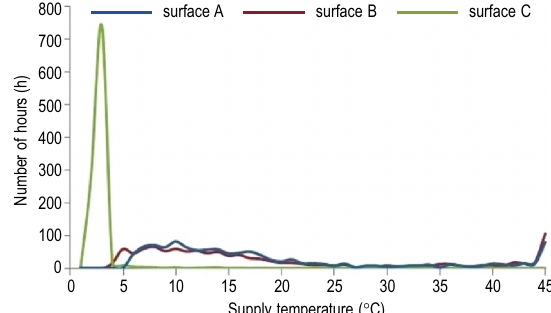
Supply temperature ( C) (cid:31) Fig. 13. Operation time as a function of supply temperature resulting from control strategy t surf = 3 °C